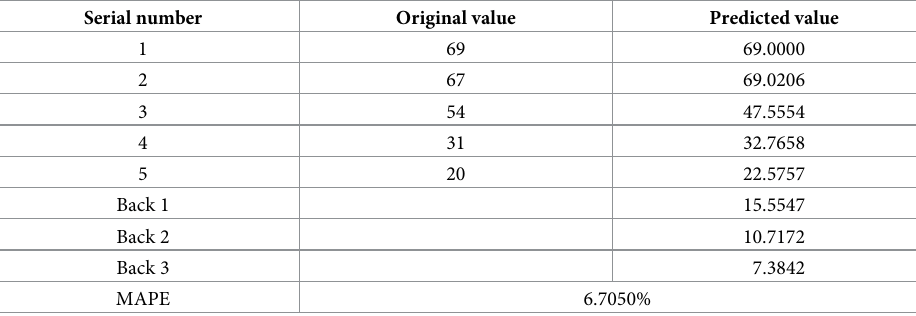
Table 5. Third iterative prediction and test table for the original sequence.